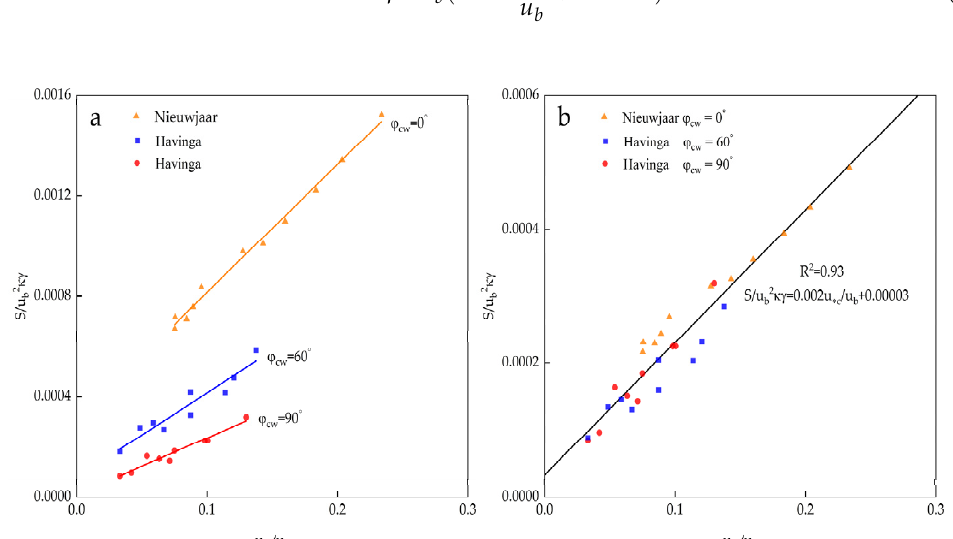
Figure 9. Gradient S evaluated from Equation (21) in lab experiments of van der Kaaij and Nieuwjaar [44] and Havinga [46]. ( a ) S / u 2 b κ as a function of u ∗ c / u b ; ( b ) S / u 2 b κγ as a function of u ∗ c / u b